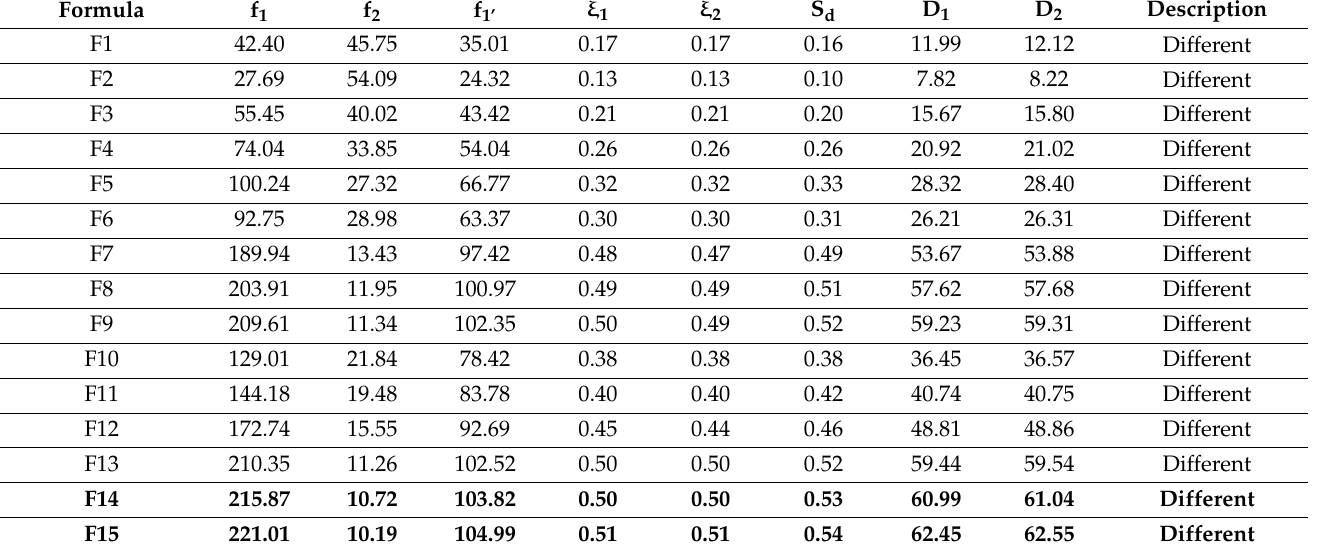
Table 5. Parameters for assessing the similarity and difference between dissolution data of plain Tel versus